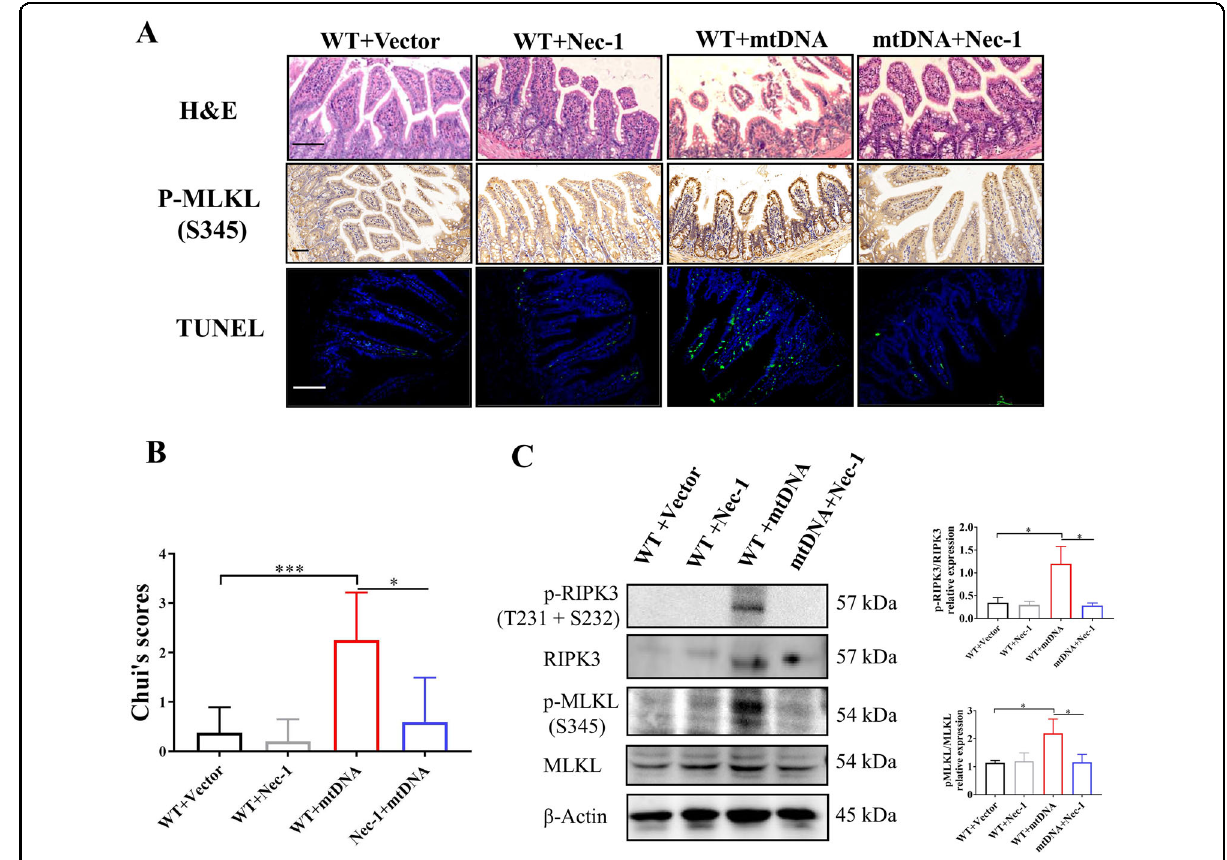
Fig. 2 mtDNA contributes to necroptosis-dependent intestinal injury. A Representative images of intestinal H&E, IHC (p-MLKL), and TUNEL staining in wild-type mice after the intraperitoneal injection of 5 mg/kg mtDNA or the treatment of nec-1. B Intestinal injury was assessed by Chui ’ s score. C Western blot was conducted to analyze necroptosis signaling. Scale bars = 50 μ m. Data were shown as the mean ± SD. * P < 0.05, ** P < 0.01, *** P <